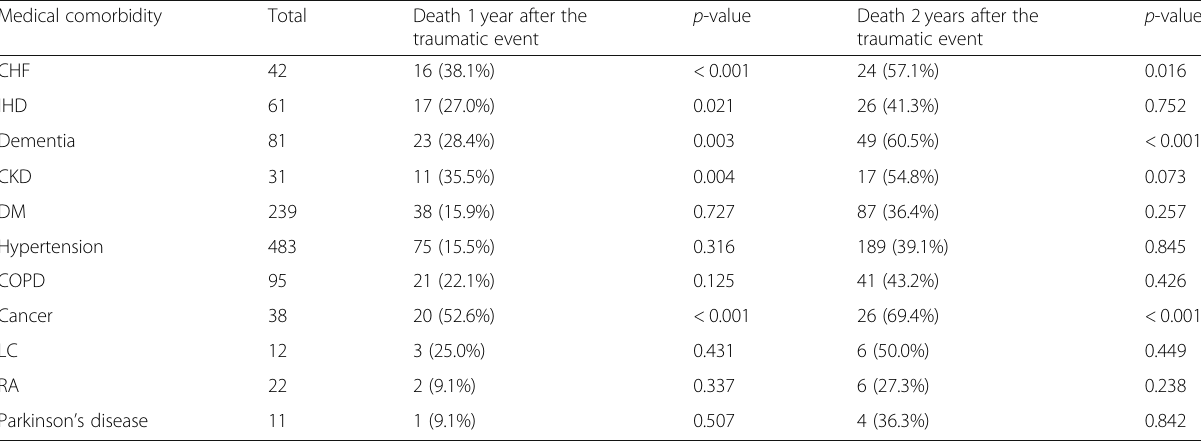
Table 4 Mortality rates of medical comorbidities Medical comorbidity